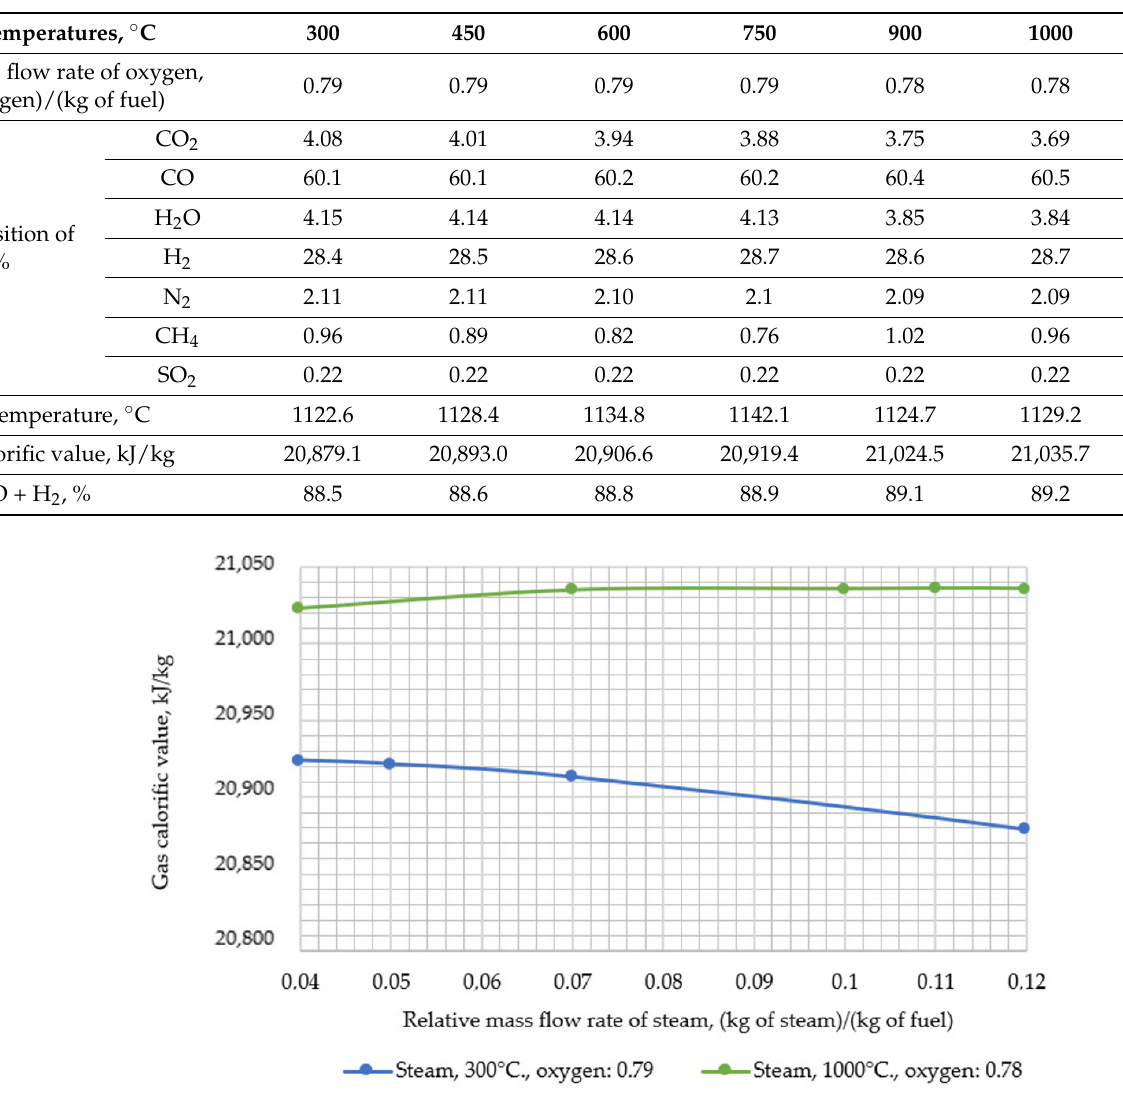
Table 6. Optimal values of output parameters for steam temperatures under consideration.